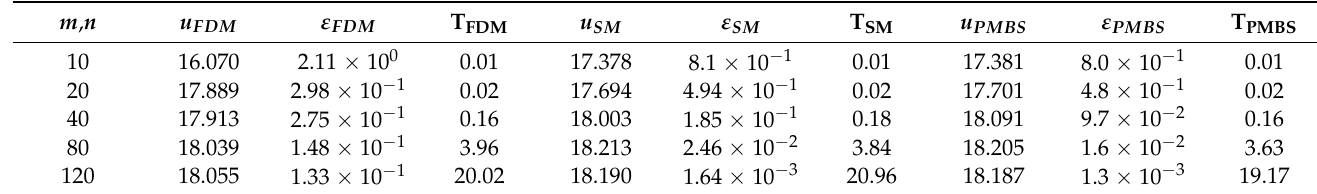
Table 1. Convergence history for Example